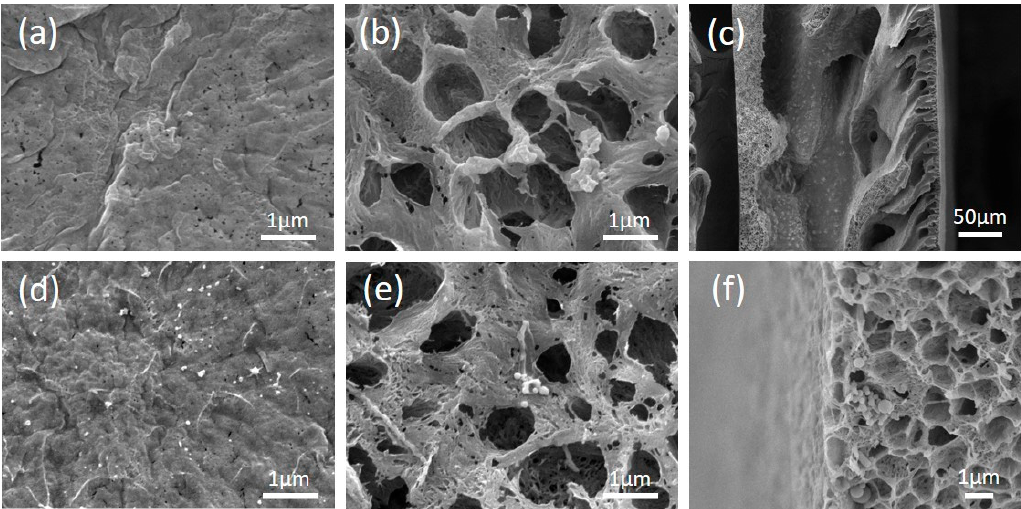
Figure 3. Top view, bottom view, and cross-sectional view of the Original#1 and the modified polyoxometalates (POMs-M#1) membrane by field emission scanning electron microscope (FESEM): ( a – c ) for the Original#1 and ( d – f ) for the POMs-M#1, respectively.